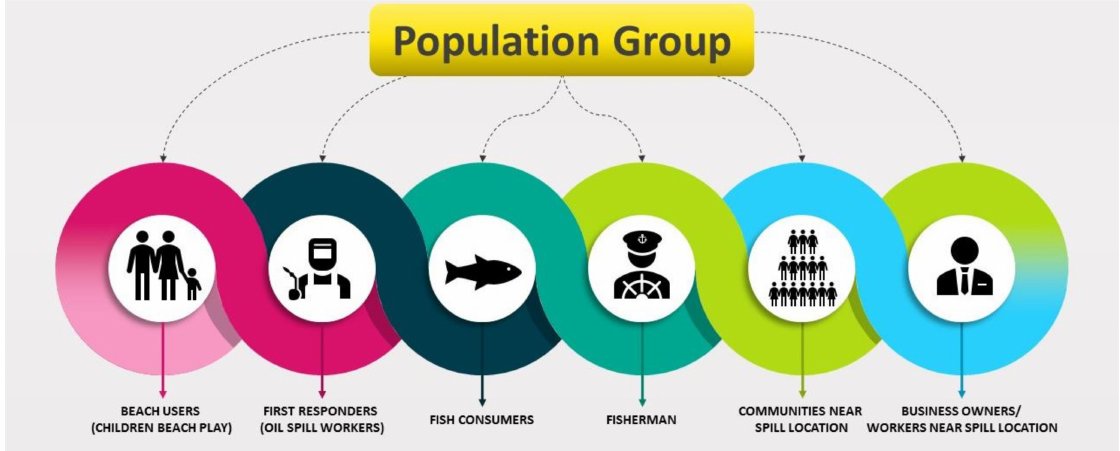
Figure 5. Population of people affected due to oil